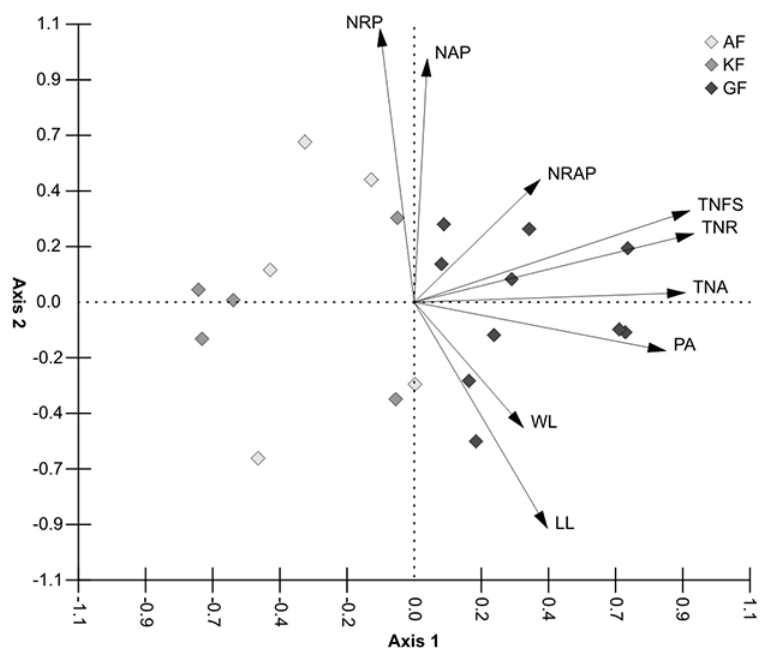
Fig. 3 Results of principal component analysis (PCA) based on the characteristics of the Arnica montana population. TNR – total number of rosettes in the population; TNFS – total number of flowering stems in the population; TNA – total number of rosette aggregations in the population; PA – population area; NRP – number of rosettes on the studied plot; NAP – number of rosette aggregations on the studied plot; NRAP – number of rosettes in the aggregation on the studied plot; LL – length of the longest leaf of rosette; WL – width of the longest leaf of rosette; AF – Augustów Forest; KF – Knyszyn Forest; GF – Grodno